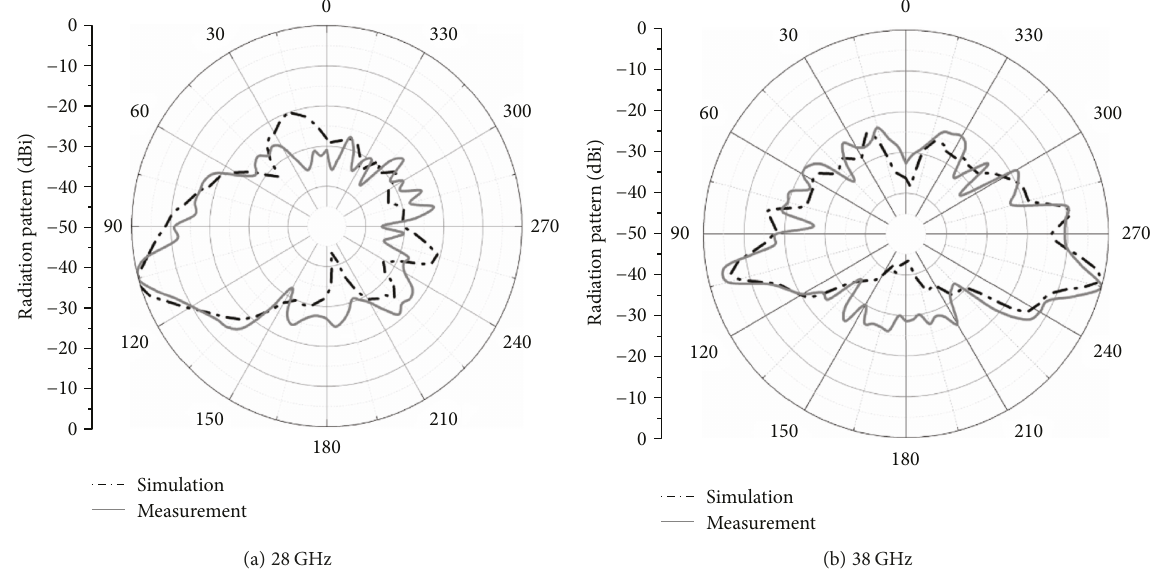
Figure 12: Dual-band SWAA radiation pattern in the azimuth